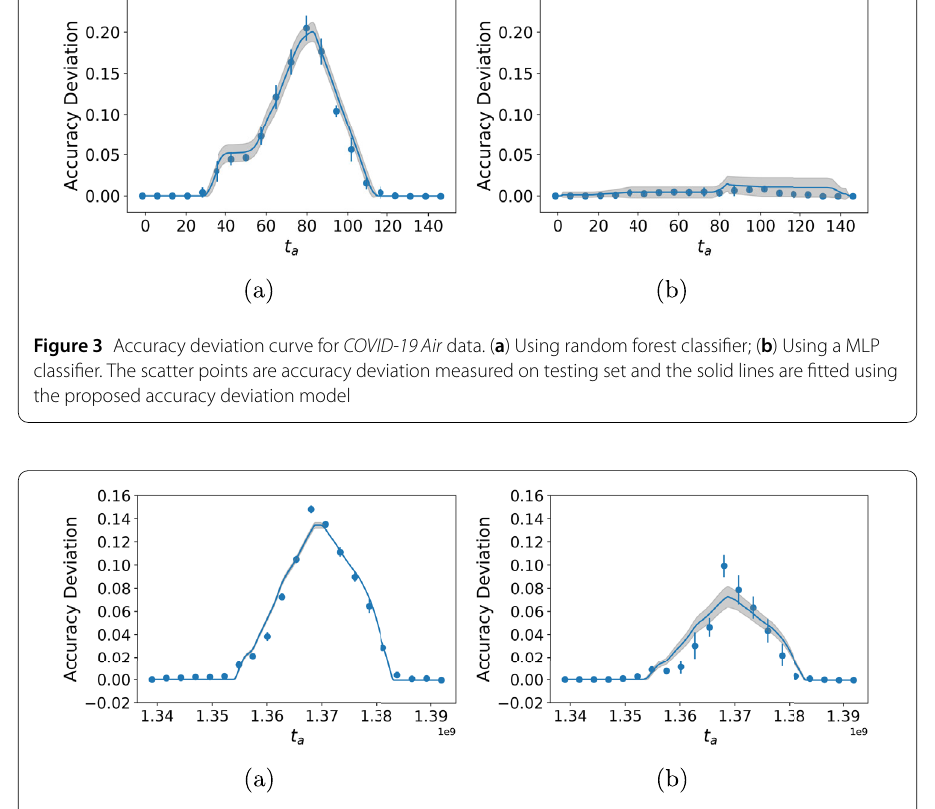
efficient, therefore we only sample 0.5% of the data (about 3.5K entries) uniformly at